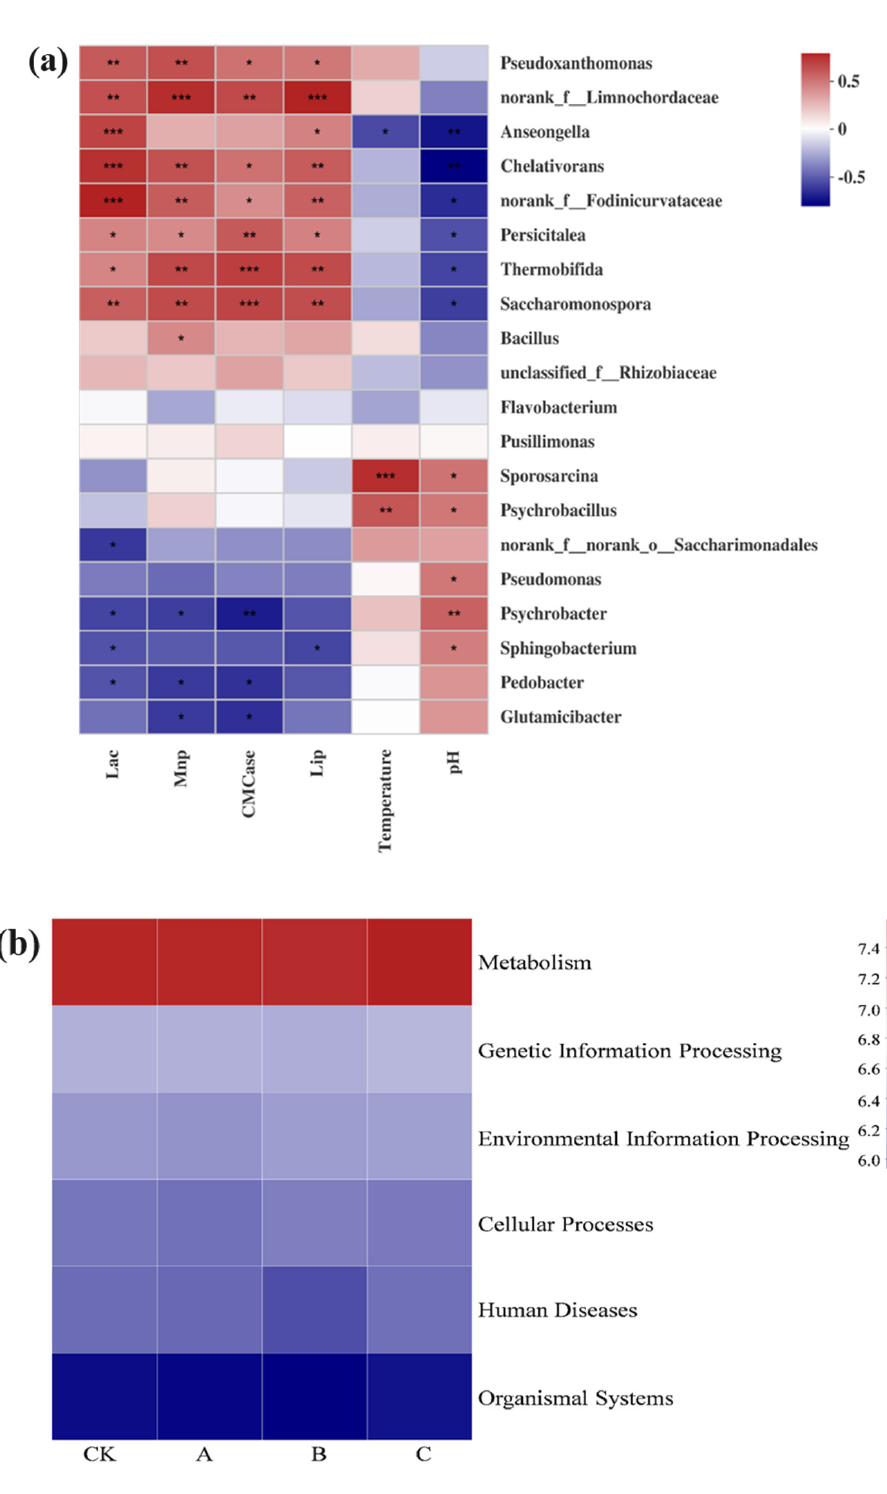
Figure 7. Correlations among enzyme activity, environmental factors, and bacteria at the species level ( a ). The color of each square in the heat map represents the correlation coefficient from Spearman correlation; the right side of the legend is the color range of different r values. Red is positive and blue is negative. The value of p < 0.05 is marked with *, p < 0.01 is marked with **, and p < 0.001 is marked with ***. Analysis of microbial metabolism functions at Level 1 by PICRUSt ( b ).